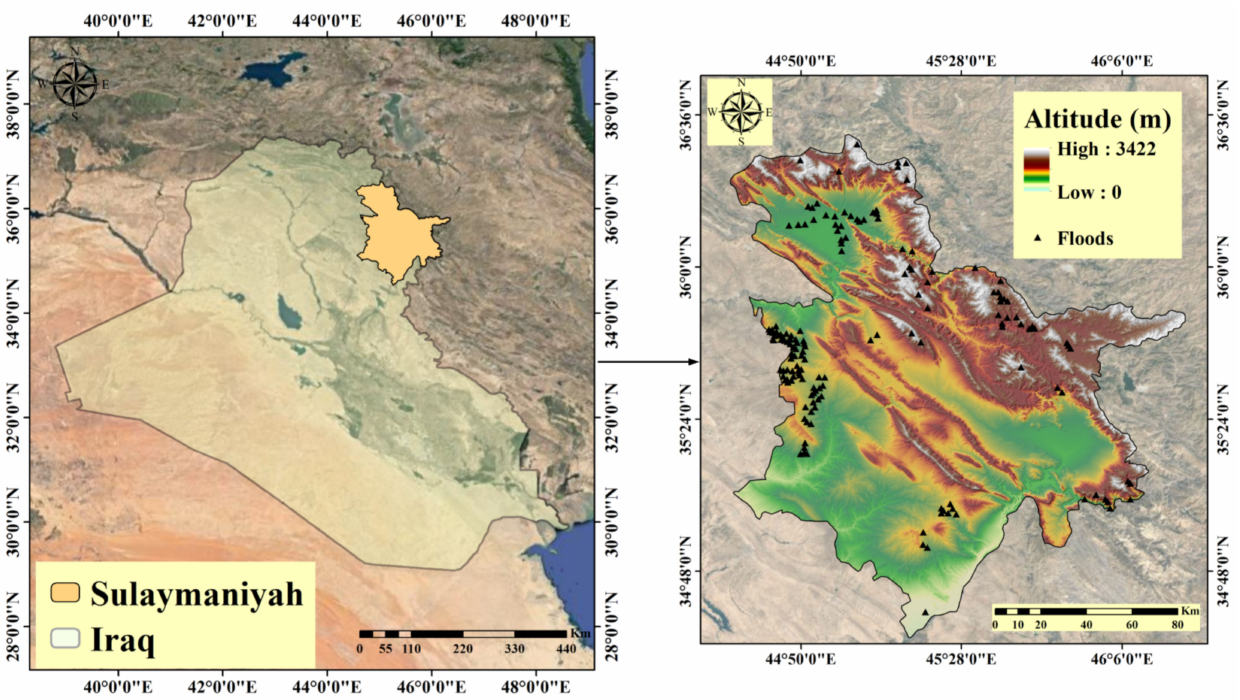
Figure 2. Location of Sulaymaniyah province in Iraq with flood points.